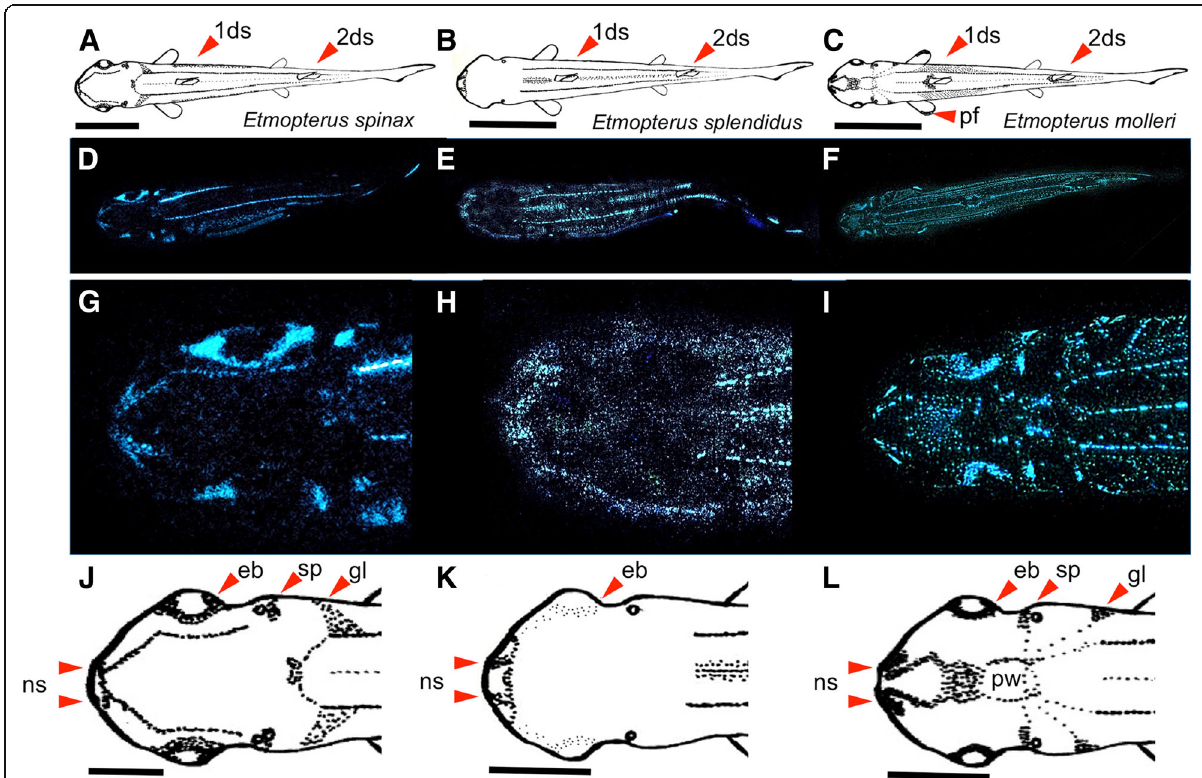
Fig. 1 Dorsal luminescent patterns of E. spinax, E. splendidus and E. molleri . Schematic view of the dorsal patterns; images of dorsal luminous patterns and head close-up; schematic representation of the dorsal head luminous patterns of E. spinax ( a , d , g , j ), E. splendidus ( b , e , h , k ) and E. molleri ( c , f , i , l ) respectively. 1ds: first dorsal; 2ds: second dorsal; eb: eyeball; gl: gills; ns: nostril; pf: pectoral fin; pw: pineal window; sp.: spiracle. Scale bars 8cm ( a , b , c ) and 2cm for ( j , k , l